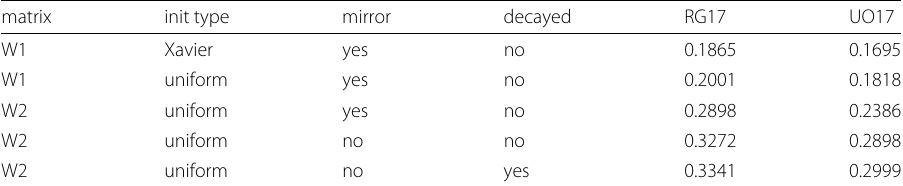
Table 3 Mean global performance (NDCG@100) of StreamWalk with different settings on the first three day of RG17 and UO17 respectively